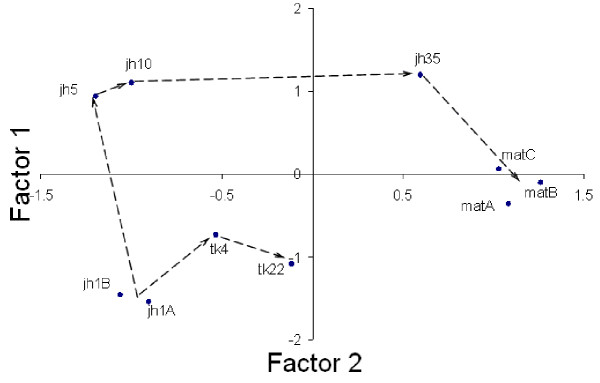
Plot of scores of first two PCA factors. Vectors are drawn to show the trajectories of the two gradients of habitat recovery. The chronosere codes are as follows- jh1A, 1B, 5, 10 &35: jhum fallows ranging from 1 to 35 years; tk4 &22: teak plantation 4 and 22 years old; matA, B, &C: mature forest plots. See methods and Table 1 for more details.